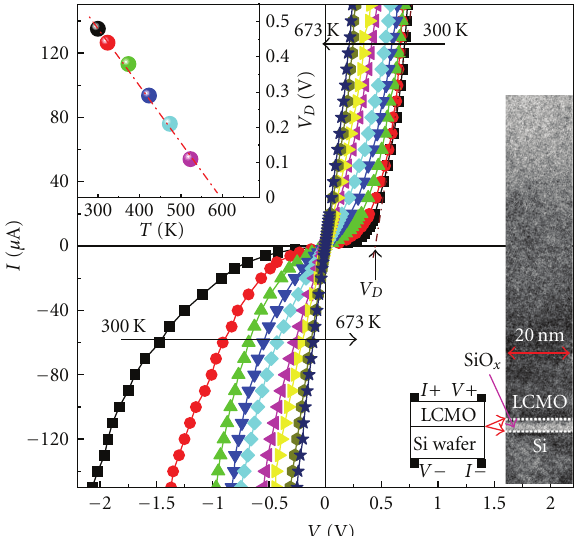
Figure 1: The I-V curves of LCMO/SiO x /Si heterojunction measuring in a wide temperature range from 300 to 673K. The right inset is the schematic structure of the electrode settings and the cross-sectional TEM image. The left inset shows the di ff usion potential V D as a function of